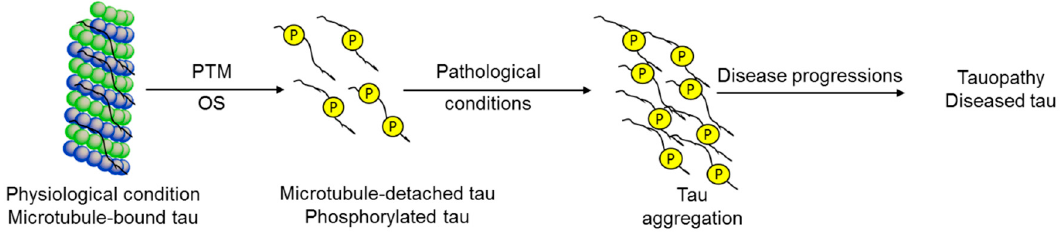
Figure 1. Oxidative stress-mediated tauopathy.